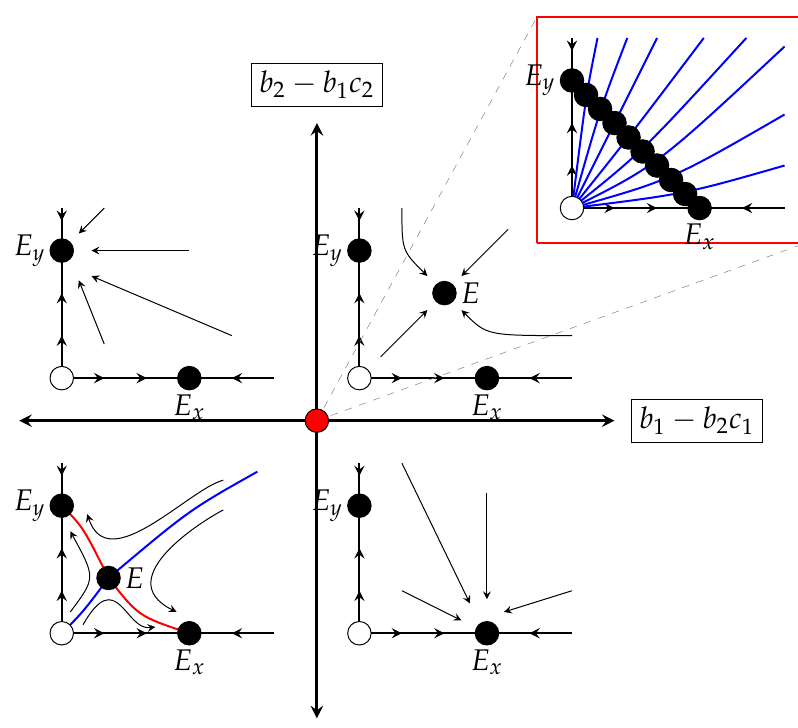
Figure 2. Global dynamics of System